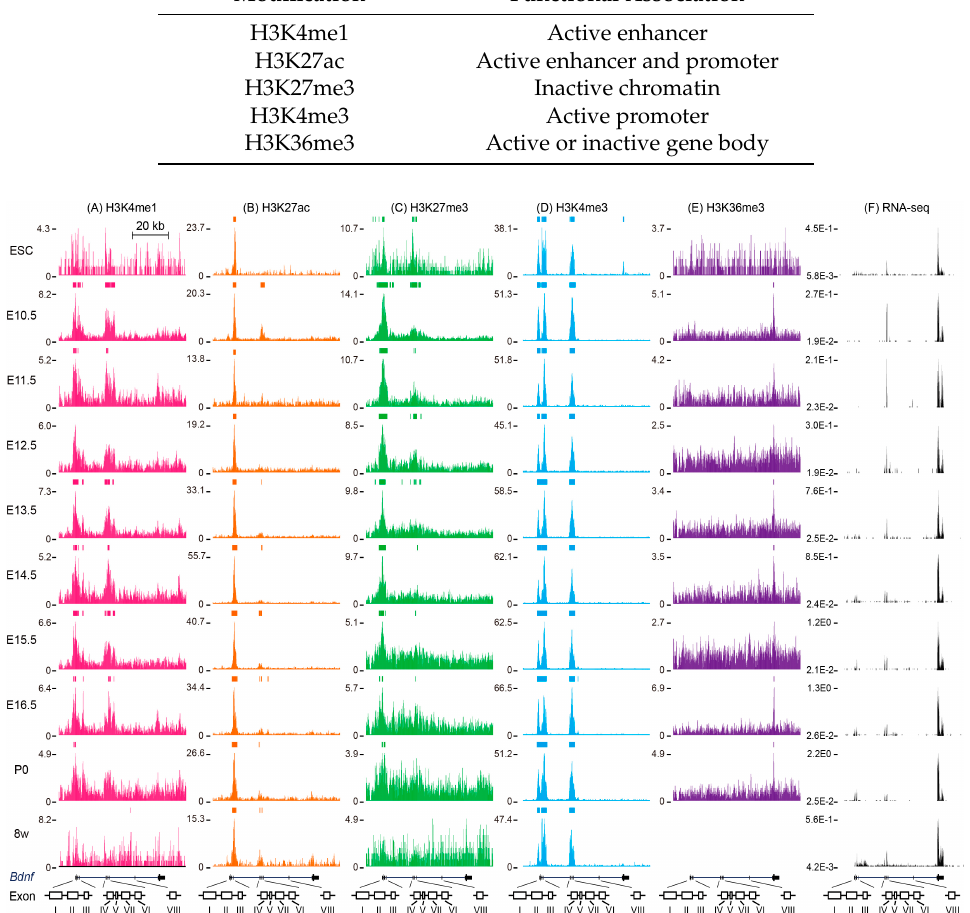
Figure 2. Histone modifications at mouse Bdnf gene during brain development. All data were collected from the ENCODE database and visualized in the University of California Santa Cruz (UCSC) genome browser with the alignment to mouse genome assembly (GRCm38/mm10). The bars located above